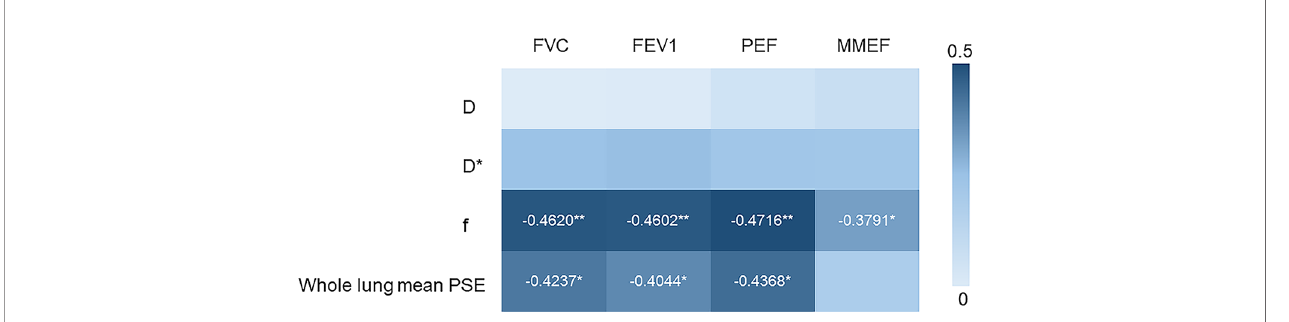
FIGURE 1 | Heat map depicting Spearman ’ s correlations between the PFTs (FVC, FEV1, PEF, MMEF) and imaging parameters (D, D*, f from IVIM-DWI and whole lung mean PSE). (*p < 0.05, **p <